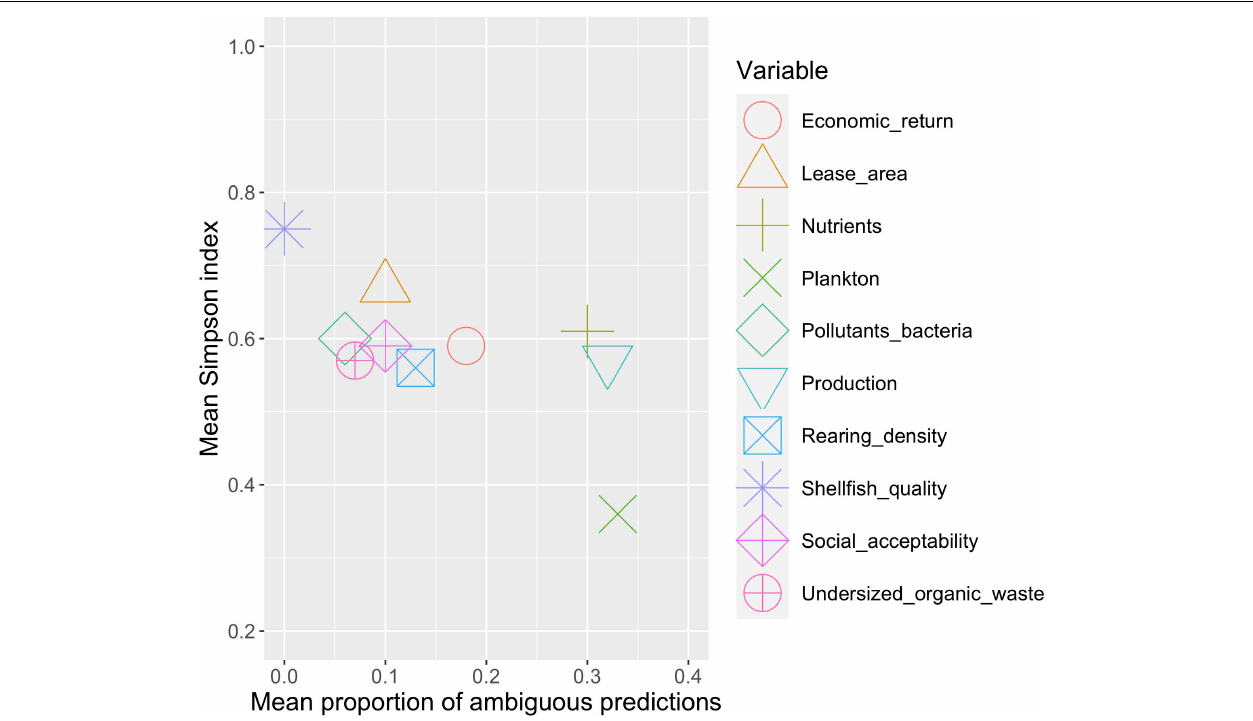
FIGURE 8 | Summary of variable-specific uncertainty in model predictions: x -axis corresponds to the mean over all scenarios of the proportion of sign-uncertain (i.e., ambiguous) predictions across all models; y -axis provides an estimate of consistency in sign predictions across models for any scenarios. If all model predictions are sign-consistent, Simpson index will be equal to 1. Conversely, if model sign predictions are equally distributed between positive, negative, neutral or ambiguous then Simpson index will be